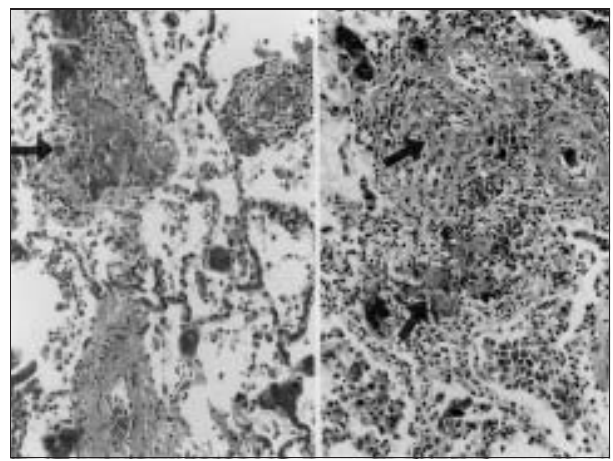
Figure 1) Left Small pulmonary arteries showing intimal fibrosis, prominent endothelial cells and an area of fibrinoid necrosis (arrow). Right